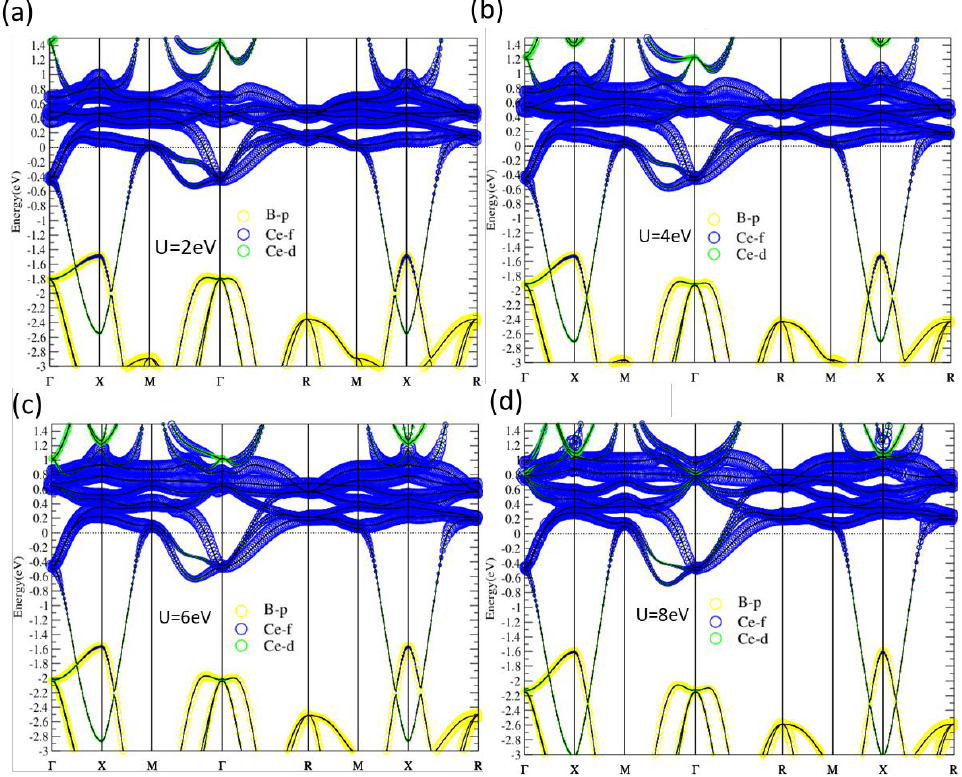
Figure 5. ( a – d ) CeB 6 band structures given from PBE + SOI + U with U = 2, 4, 6, 8 eV, respectively. The sizes of blue, green and yellow circles indicate components from Ce-f, Ce-d and B-p orbitals, respectively.